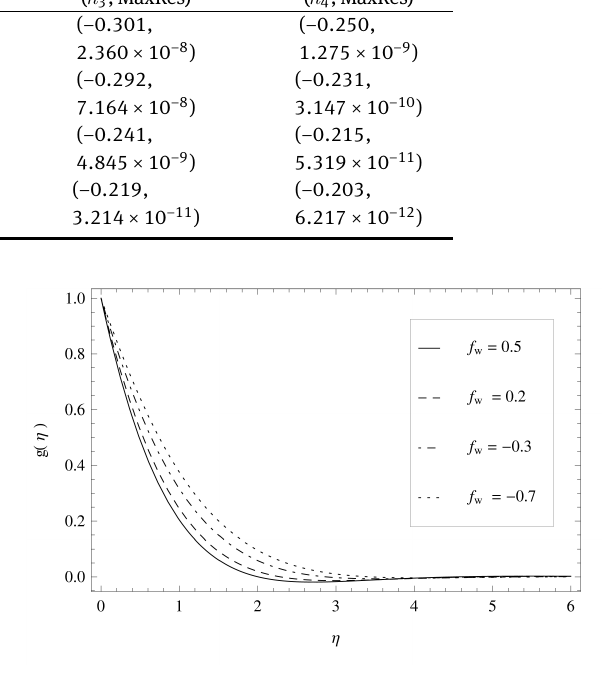
Fig. 11: The influence of a parameter f w on g ( η ) for λ = 0.4, We = 0.1, α = 0.3, M = 0.2 and (cid:126) =